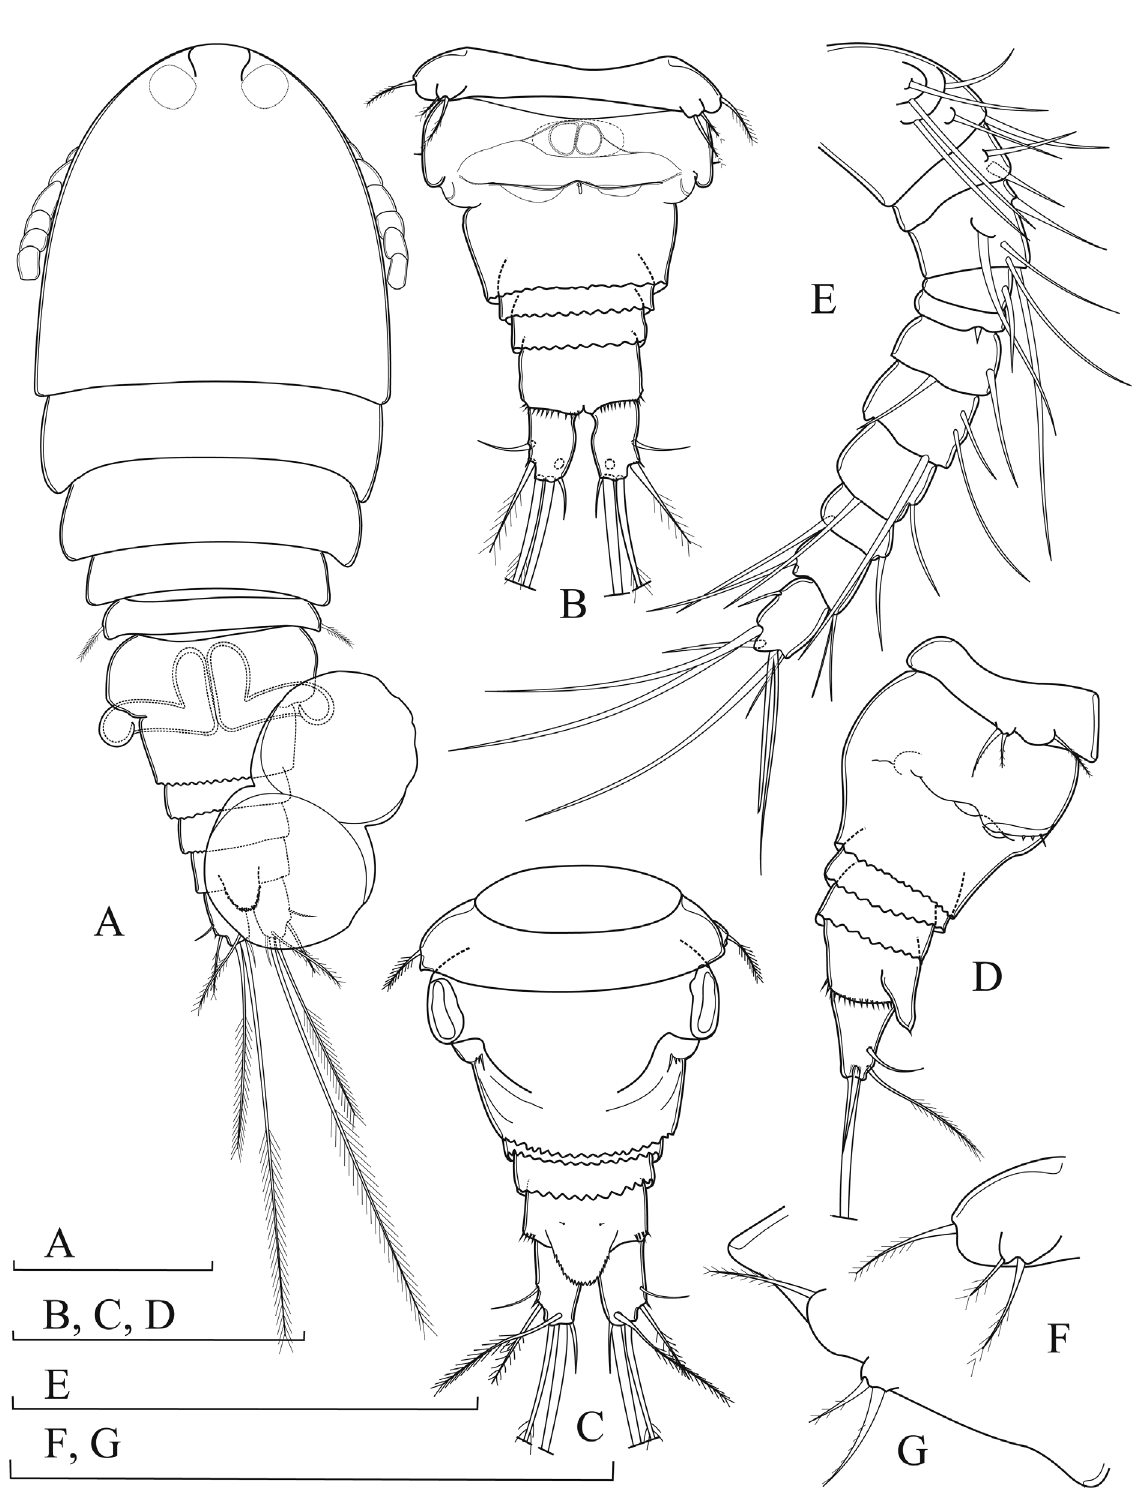
Fig. 1. Siamcyclops cavernicolus gen. et sp. nov., holotype, ♀. A . Habitus, with spermatophores and egg sac, dorsal view. B . Urosome, ventral view. C . Urosome, dorsal view. D . Urosome, lateral view. E . Antennule. F . P5, ventral view. G . P5, lateral view. Scale bars: 100